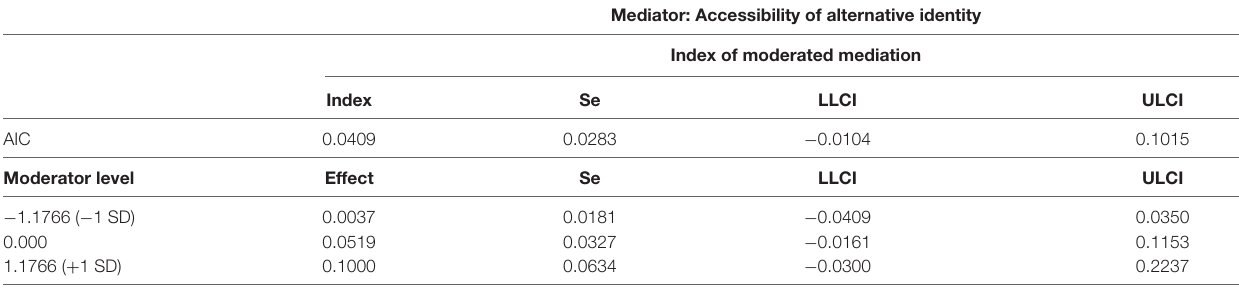
TABLE 6A | Results of the mediation effect of the accessibility of alternative identity under alternative identity clarity situation. Mediator: Accessibility of alternative identity